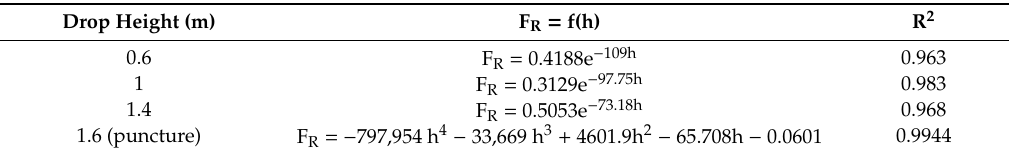
Table 4. Correlation between the impact force F R and the height h for the drop hammer weight of 100 kg.